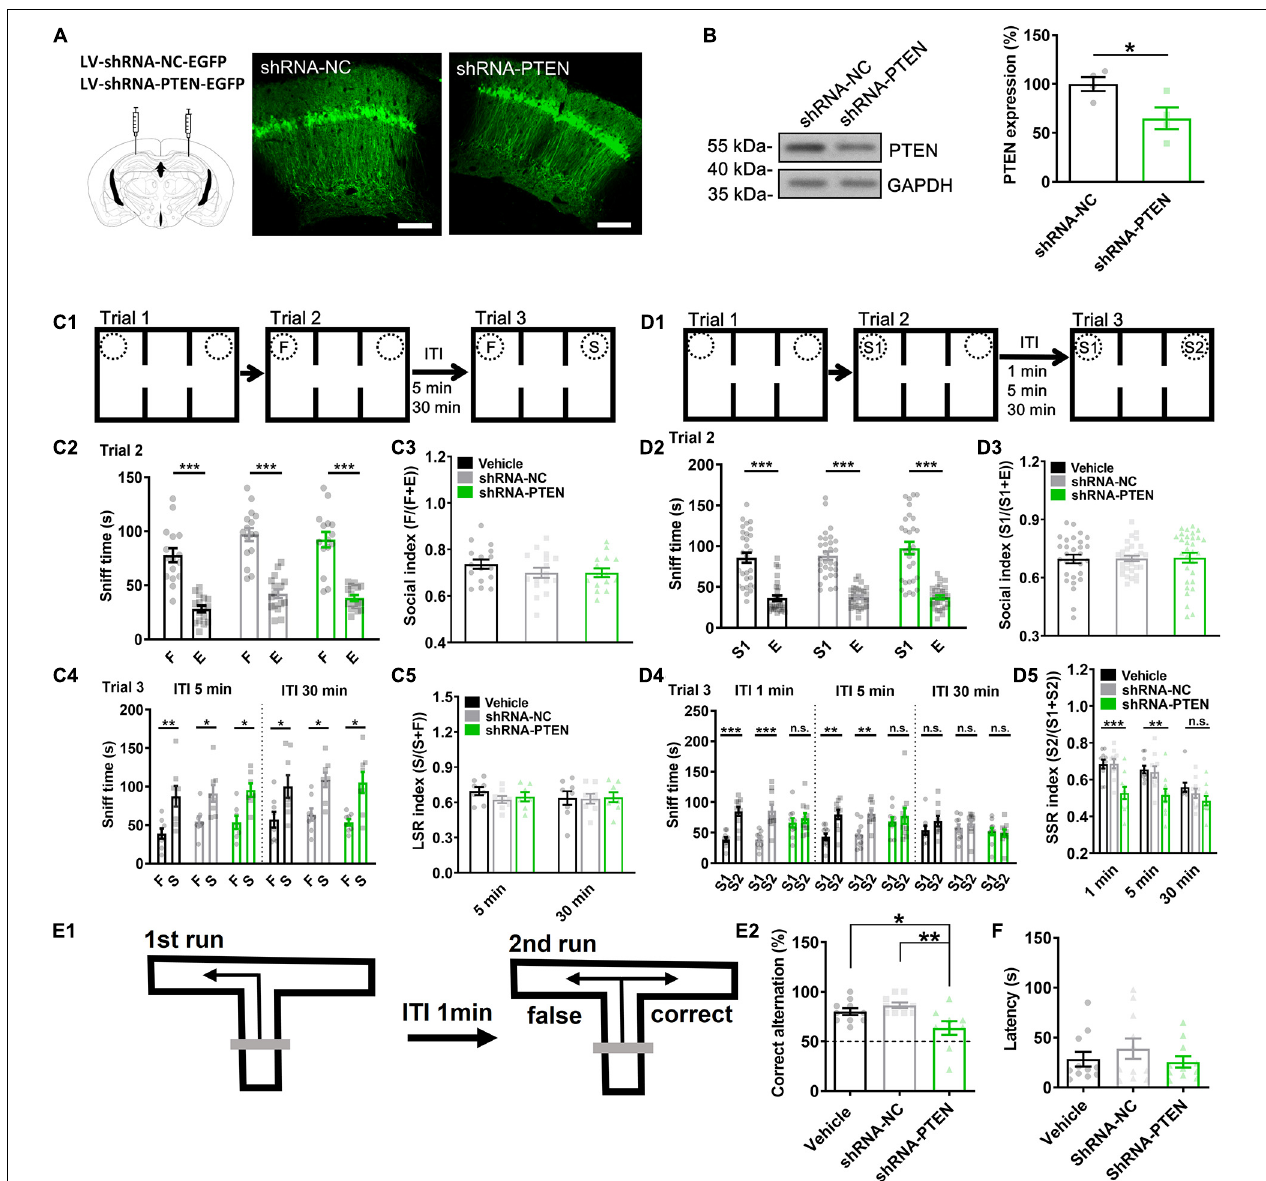
FIGURE 4 | Short-term memory-guided social recognition deficit in CA1 PTEN knock down (KD) mice. (A) Juvenile mice were injected with lentivirus (LV) containing shRNA-NC-EGFP (negative control) or shRNA-PTEN-EGFP in dorsal CA1 regions. Three weeks after injection, robust EGFP was expressed in CA1 neurons indicating successful infection. Calibration bars, 200 µ m. (B) Western blot of the EGFP expressed CA1 samples showed significant PTEN KD ( n = 4/group; * P < 0.05). (C1) Schematic of experimental paradigm for LSR. (C2) All the mice explored more with F vs. E in trial 2. (C3) All groups showed normal sociability in trial 2 by exploring F vs. E ( n = 16 for Vehicle, n = 16 for shRNA-NC, n = 15 for shRNA-PTEN; F ( 2 . 44 ) = 1.102, P = 0.3412). (C4) All groups explored more with S vs. F regardless of the ITIs in trial 3(ITI 5 min, Vehicle, t = 4.468, P = 0.0029; shRNA-NC, t = 3.235, P = 0.0143 ; shRNA-PTEN, t = 3.340, P = 0.0156; ITI 30 min, Vehicle, t = 2.438, P = 0.0287; shRNA-NC, t = 3.172, P = 0.0157 ; shRNA-PTEN, t = 3.30, P = 0.0131; * P < 0.05; ** P < 0.01). (C5) All groups expressed normal LSR index regardless of the ITIs ( n = 8/group, but n = 7 for shRNA-PTEN group with the ITI for 5 min. ITI 5 min, F ( 2 , 20 ) = 1.189, P = 0.3253. ITI 30 min, F ( 2 , 21 ) = 0.01747, P = 0.9827). (D1) Schematic of experimental paradigm for SSR. (D2) All the mice explored more with S1 vs. E in trial 2. (D3) Sociability in trial 2 by exploring S1 vs. E was intact in all groups ( n = 29 for Vehicle, n = 30 for shRNA-NC, n = 30 for shRNA-PTEN, F ( 2 . 86 ) = 0.02262, P = 0.9776). (D4) The shRNA-PTEN group explored with S2 vs. S1 with similar time in ITI 1 and 5 min compared to that in Vehicle (0.01 M PBS) or shRNA-NC group. All group explored with S2 vs. S1 similarly in ITI 30 min. (D5) SSR index in trial 3 by exploring S1 vs. S2 was impaired in shRNA-PTEN group with the ITI for 1- or 5-min (ITI 1 min, F ( 2 , 27 ) = 10.82, P = 0.0004. Tukey’s post hoc test. Vehicle vs. shRNA-NC, P = 0.9984; Vehicle vs. shRNA-PTEN, P = 0.0012; shRNA-NC vs. shRNA-PTEN, P = 0.0011. ITI 5 min, F ( 2 , 27 ) = 6.357, P = 0.0039. Tukey’s post hoc test. Vehicle vs. shRNA-NC, P = 0.9417; Vehicle vs. shRNA-PTEN, P = 0.0064; shRNA-NC vs. shRNA-PTEN, P = 0.0143; ** P < 0.01; *** P < 0.001). Social recognition in trial 3 by exploring S1 vs. S2 was absent in all groups with the ITI for 30 min ( n = 10/group, but n = 9 in Vehicle with ITI for 30 min. P = 0.1261, χ 2 = 4.141. Dunn’s multiple comparisons test, 30 min Vehicle vs. 30 min shRNA-NC, P > 0.9999; 30 min Vehicle vs. 30 min shRNA-PTEN, P = 0.1422; 30 min shRNA-NC vs. 30 min shRNA-PTEN, P = 0.5160; ** P < 0.01; *** P < 0.001). n.s., not significant. S, a stranger mouse; S1, a